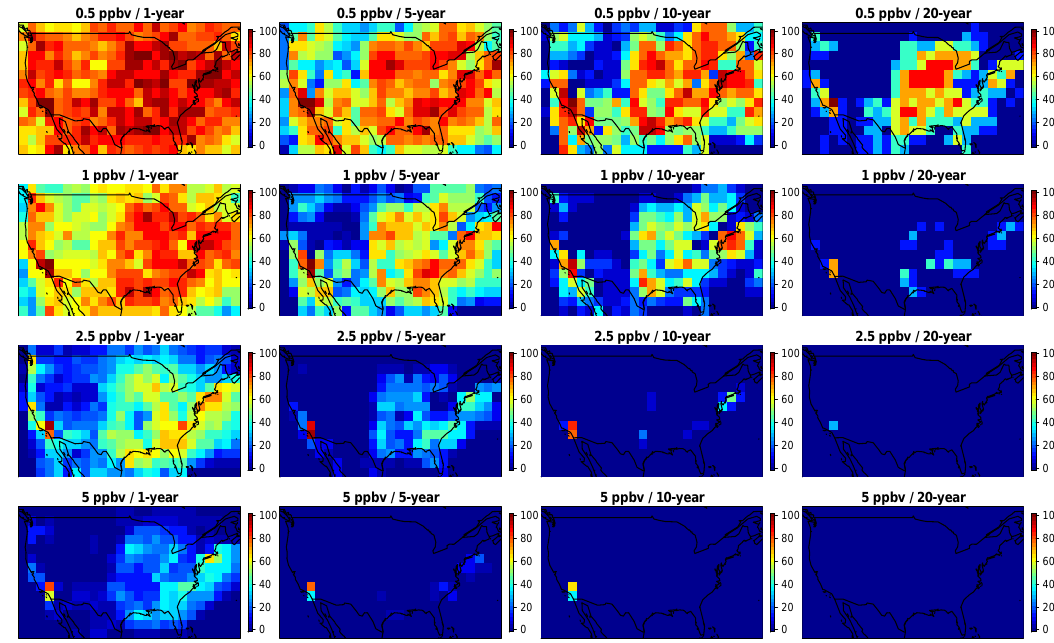
Figure 5. Spatial plots over the continental US plotting the likelihood (%) that an estimate of ozone exceeds a given threshold due to meteorological variability (rows) at the grid-cell level when using different lengths of averaging windows (columns) for the present-day CESM simulation (MOZ_2000).